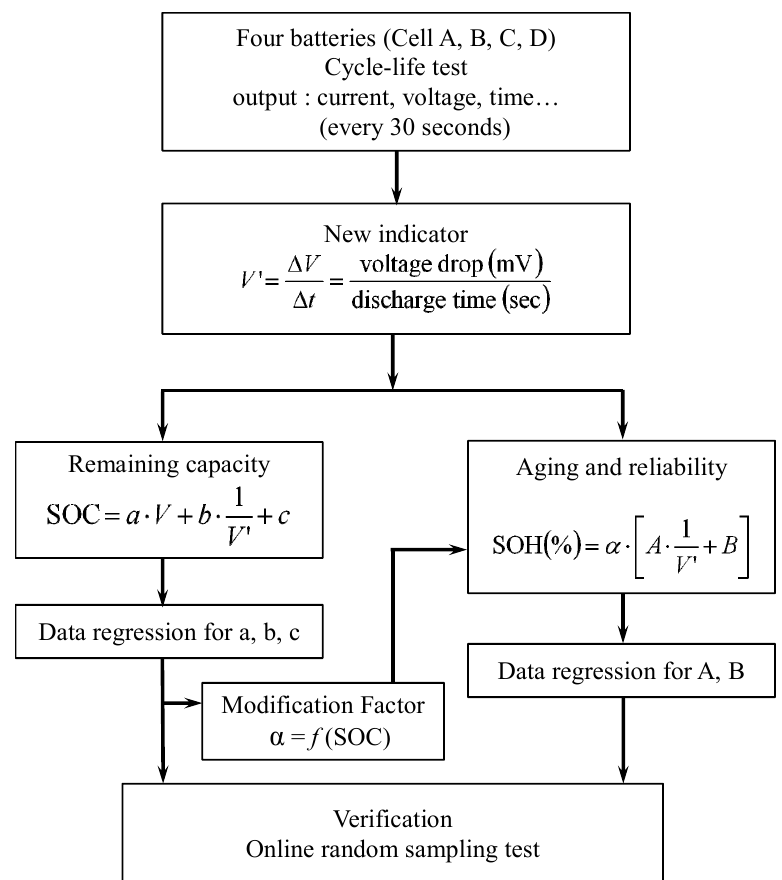
Figure 6. SOC and SOH model construction and verification process.